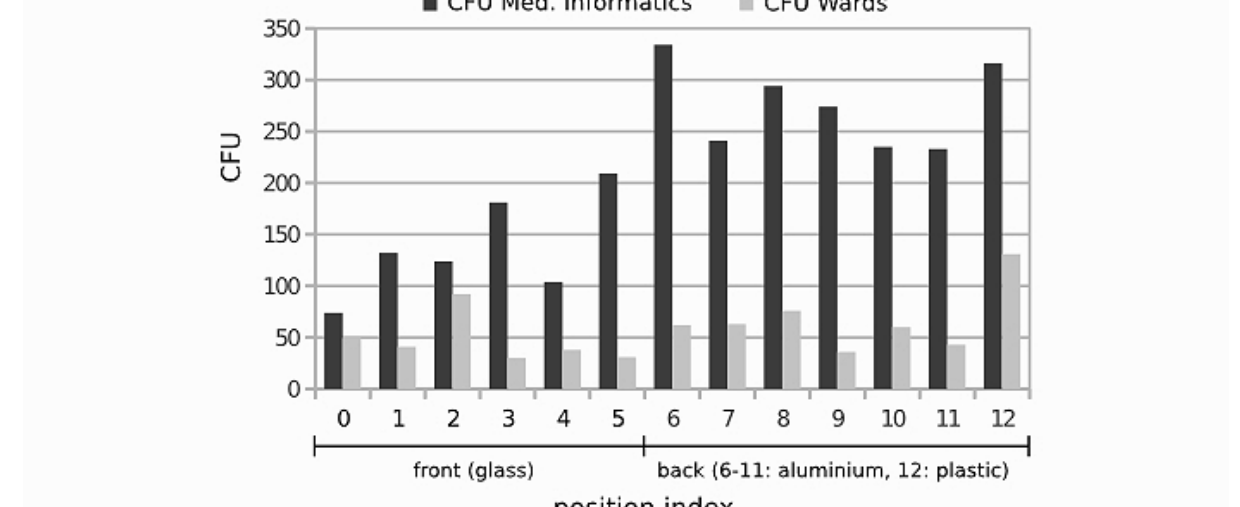
Figure 3. Histogram of CFU-count per localization samples taken from 6 corresponding devices in a clinical and nonclinical setting, stratified for position number, side, and